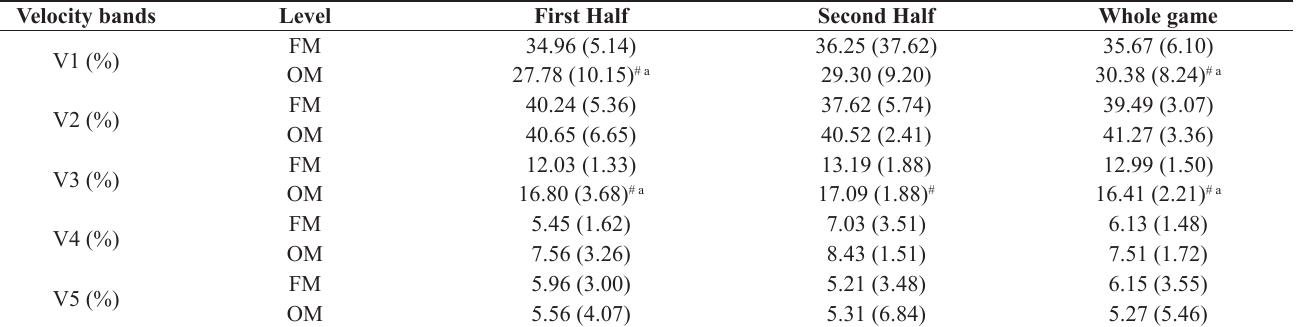
Table 2. Percentage of distance covered (%) within each of the pre-determined velocity bands for official match (OM) and pre-season friendly match (FM). Results are presented in medians (interquartile interval).